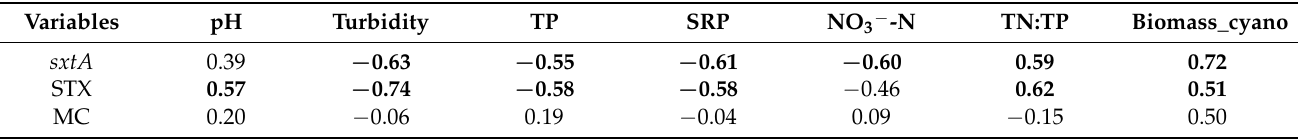
Table 2. Spearman rank correlation coefficients between environmental variables and sxtA gene, saxitoxin (STX) and TP = total phosphorus; SRP = soluble reactive phosphorus; NO 3 − -N = nitrate; TN:TP = total nitrogen and total phosphorus microcystin (MC) concentrations in Itupararanga reservoir (n = 16). Significant correlations ( p < 0.05) are shown in bold. ratio; Biomass_cyano = cyanobacterial biomass determined by pigment analysis.